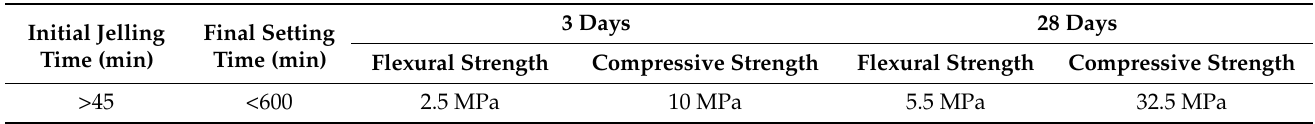
Table 3. Cement performance index.